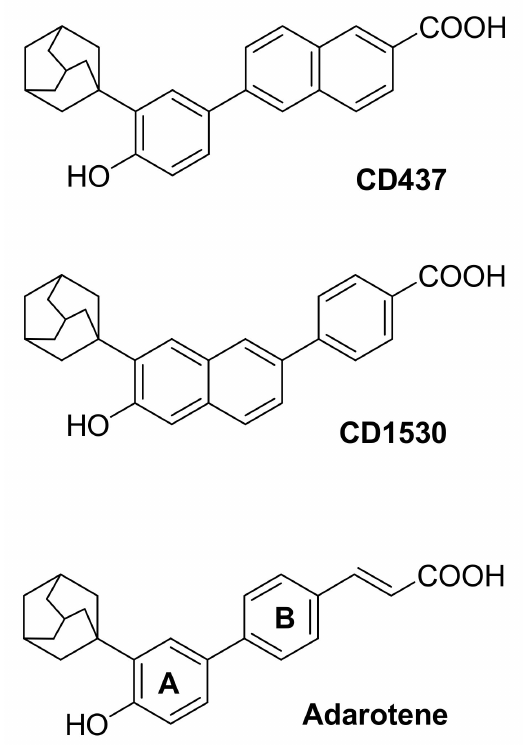
Figure 1. Structures of some representative retinoid related